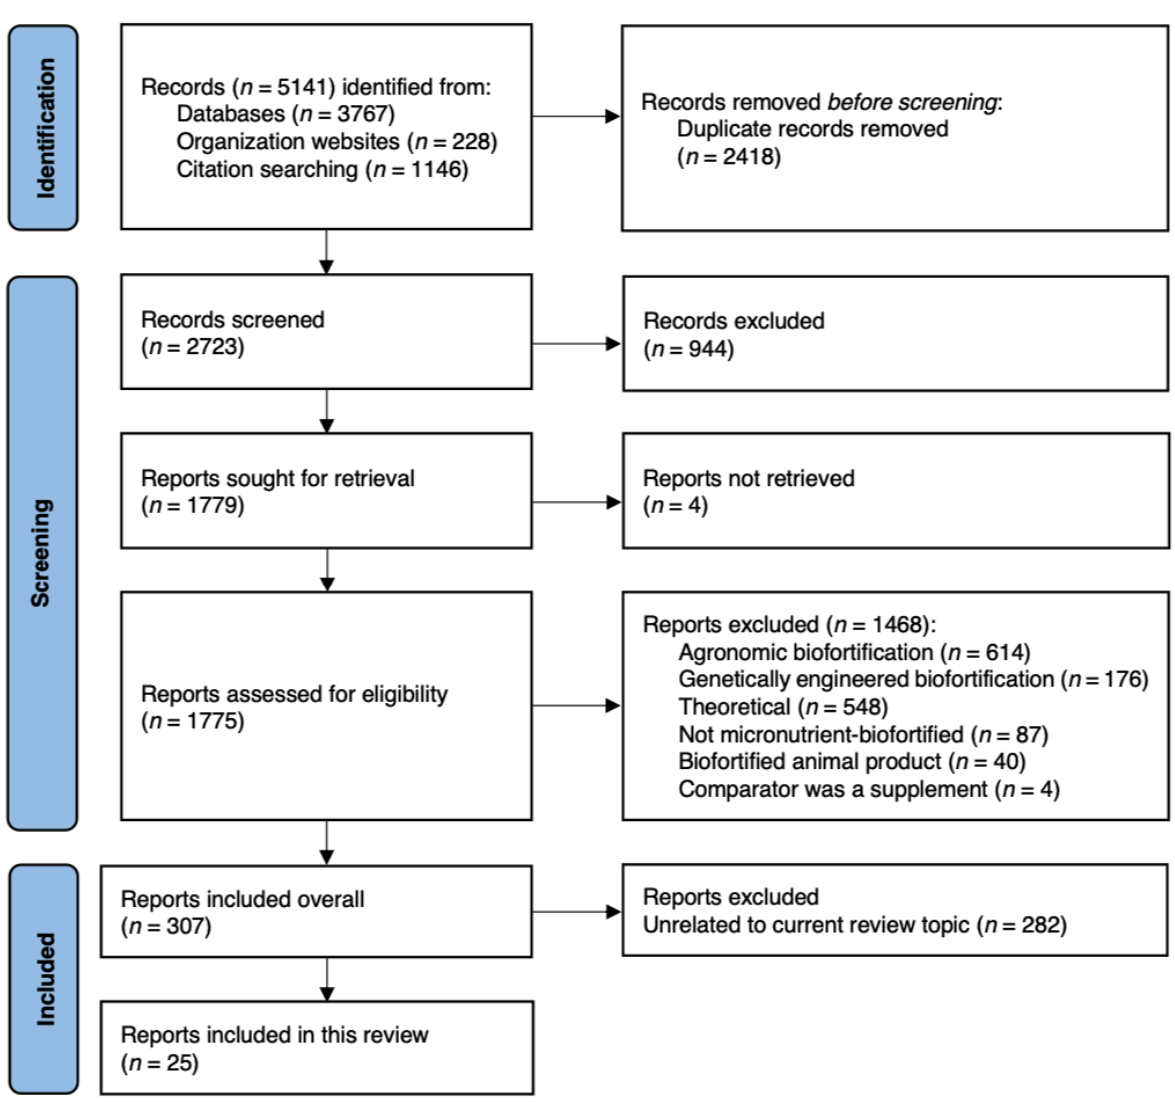
Figure 2. PRISMA Diagram